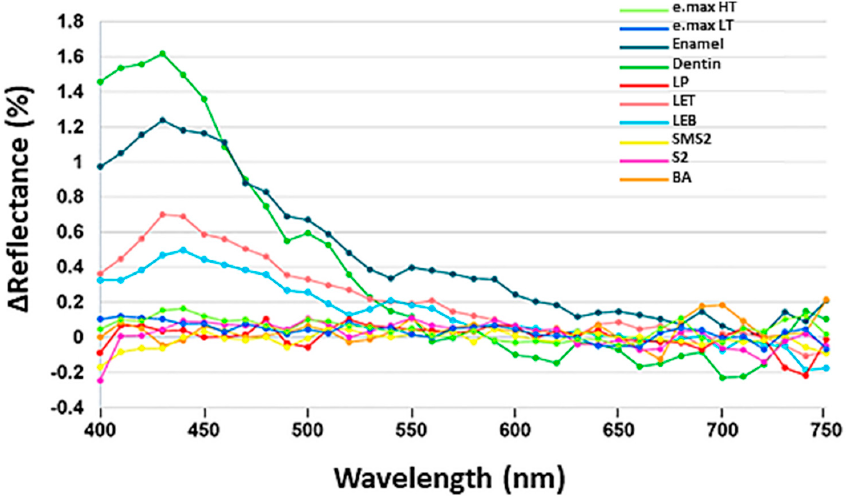
Figure 3. Differences in the reflectance under different UV illumination conditions. Of ten specimens, Figure 3. Di ff erences in the reflectance under di ff erent UV illumination conditions. Of ten specimens, four showed fluorescence. four showed